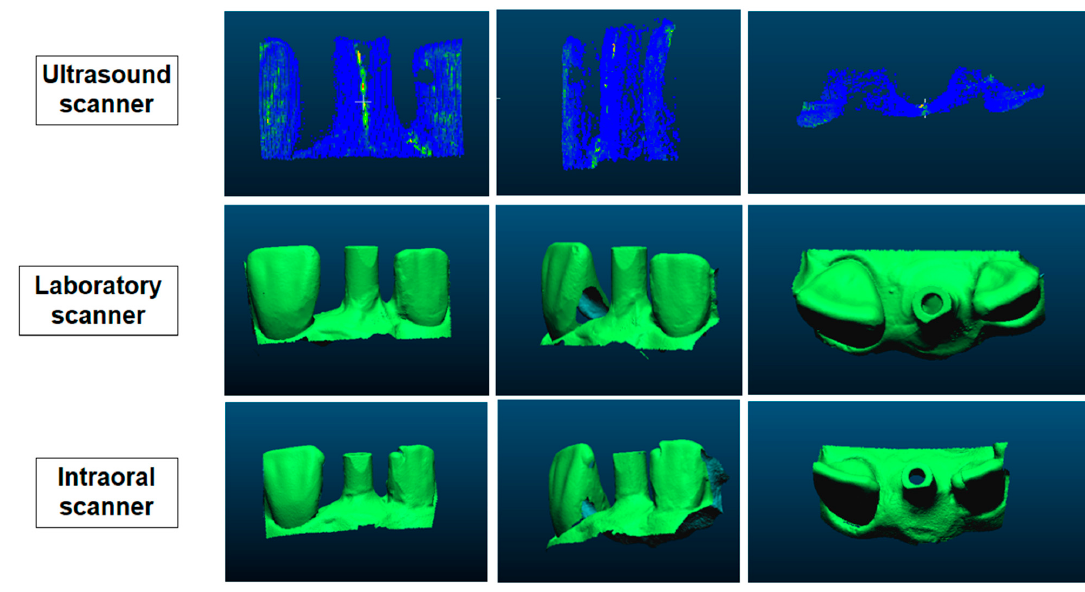
Figure 3. Digital data acquired with ultrasound (ASCII file), laboratory and intraoral (standard tessellation language files) scanners.